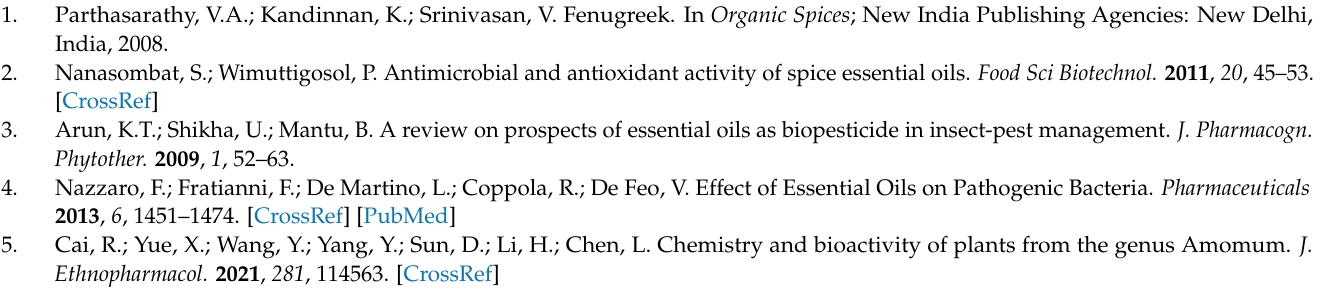
of compound 1 .; Figure S4. The 13 C-NMR (125 MHz, CDCl 3 ) spectrum of compound 1 .; Figure S5. The HSQC spectrum of compound 1 in CDCl 3 .; Figure S6. The COSY spectrum of compound 1 in CDCl 3 .; Figure S7. The HMBC spectrum of compound 1 in CDCl 3 .; Figure S8. DART-MS spectrum of compound 6 .; Figure S9. The IR spectrum of compound 6 .; Figure S10. The 1 H-NMR (500 MHz, CDCl 3 ) spectrum of compound 6 .; Figure S11. The 13 C-NMR (125 MHz, CDCl 3 ) spectrum of compound 6